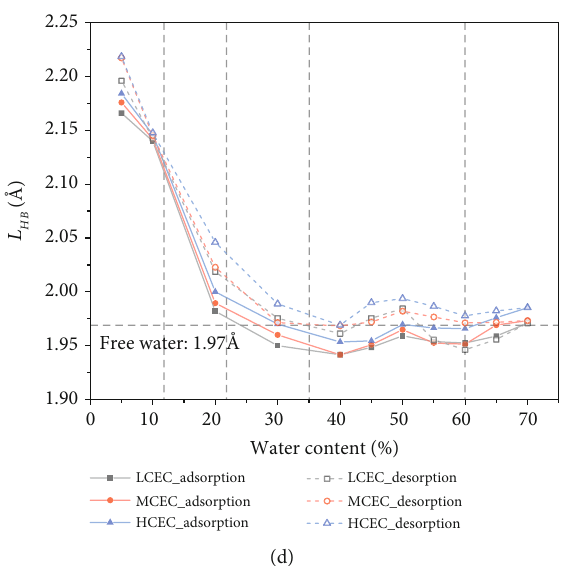
Figure 7: Changes in the number and length of hydrogen bonds: (a) Na-Mnt, (b) Ca-Mnt, (c) Na-Mnt, and (d)